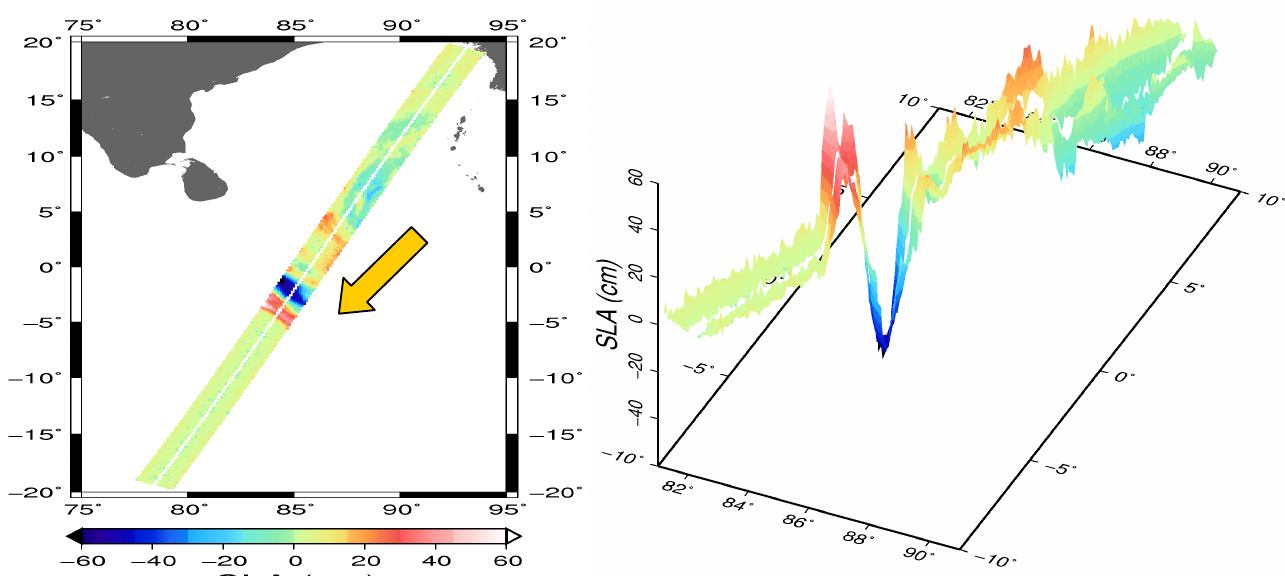
Figure 20. (a) Simulated sea level anomaly as would have been observed by an interferometer onboard the Jason platform over December 2004 tsunami and determination of the wave direction (yellow arrow) (b) 3D view of the observations (azimuth, range, height).